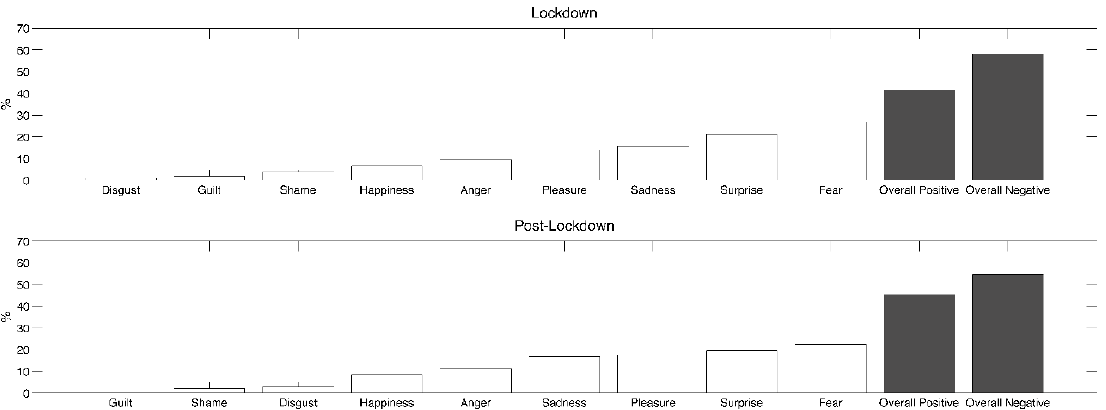
Figure 2. Percentage of each assessed emotion (white bars) reported in dreams during total lockdown